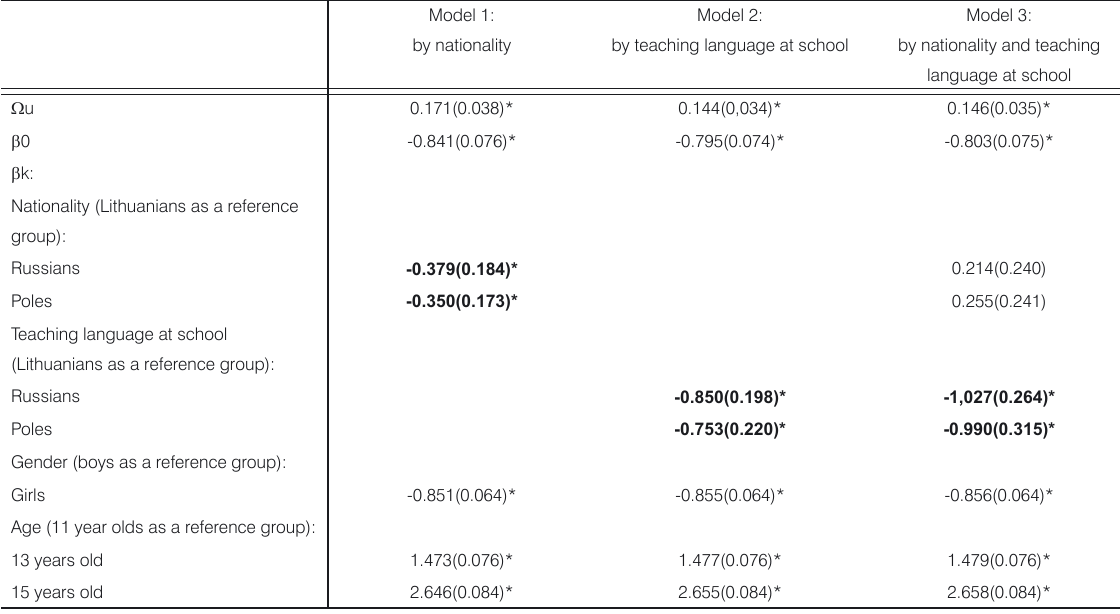
Table 4. Analysis of data of respondents, who “tried smoking” by nationality and teaching language at school: results of multiple regression